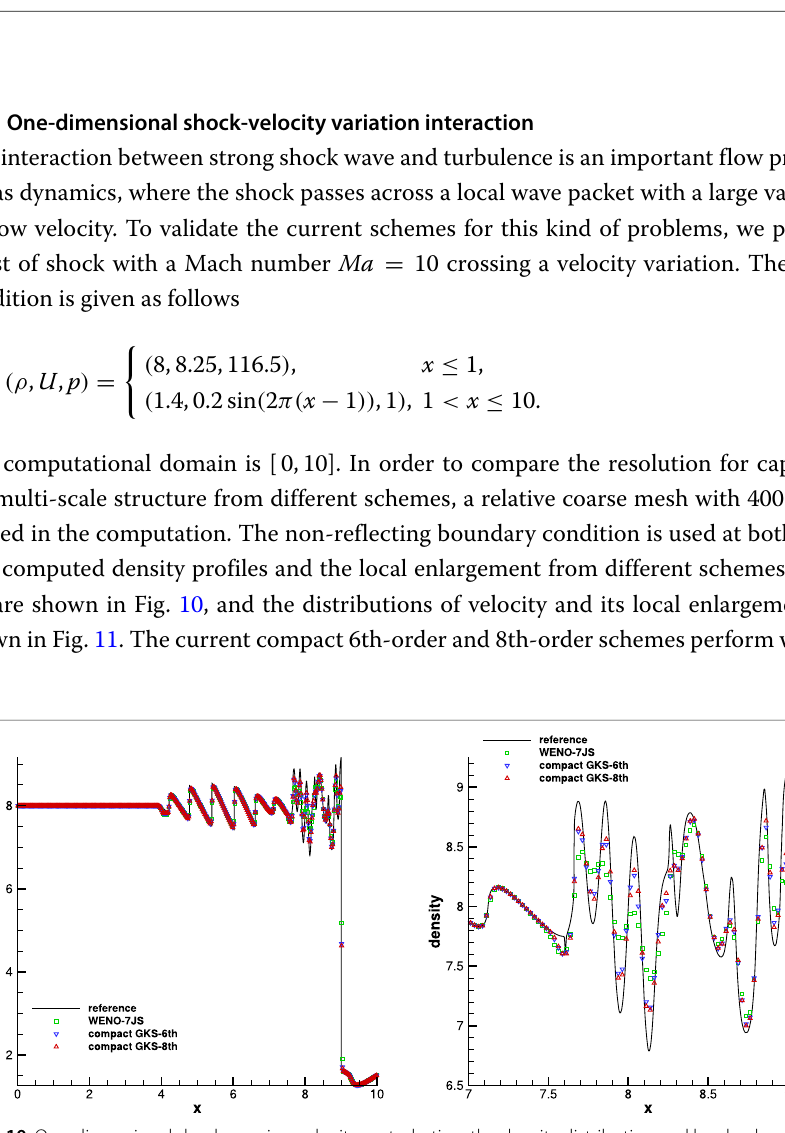
Fig.10 One-dimensional shock crossing velocity perturbation: the density distribution and local enlargement from WENO-7JS non-compact GKS, 6th-order and 8th-order compact GKS at t = 0.8 with 400 mesh